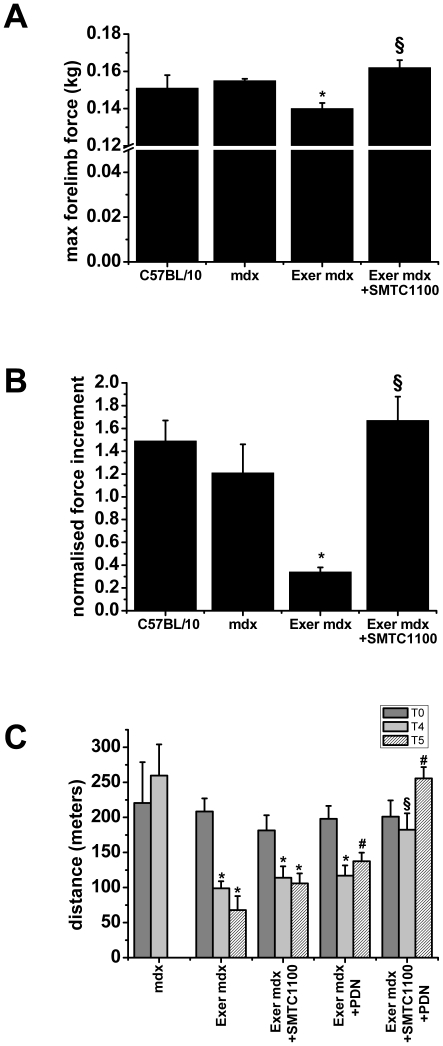
Effect of SMT C1100 on in vivo parameters of
exercised mdx mice.(A) Maximal fore limb strength after 4 weeks of either exercise and/or
drug treatment. The values are mean ± SEM from the number of
animals shown in each bar (B) Normalized force increment, i.e.
difference between the mean values of normalized fore limb strength at
time 4 and at time 0. Normalized force values have been calculated for
each mouse as the ratio of maximal fore limb strength to mouse body
weight. The values are mean ± SE. The SE of ΔNF has been
calculated as detailed elsewhere [14], [21].
For (A) and (B) statistical significance between groups was evaluated by
ANOVA test for multiple comparison (F-values) and Bonferroni t-test
post hoc correction. Significantly different versus
*sedentary mdx and §Exer
mdx; p<0.05; (C) Resistance to treadmill
running, calculated as the maximal distance the mouse can run when
undergoing a single bout of treadmill exercise. The values are mean
± SEM from 3–7 mice and show the maximal distance run (in
meters) at T0 (start of forced exercise and dosing) and after four (T4)
and five weeks (T5). Statistical significance between groups was
evaluated by ANOVA test for multiple comparison (F-values) and
Bonferroni t-test post hoc correction. Highly
significant differences were observed between groups and within groups
at the different ages (F>10; p<0.005). The symbols show
statistical differences *versus sedentary mdx at T4
and #versus vehicle-treated exercised mdx at either T4
or T5 (p<0.05 and less).